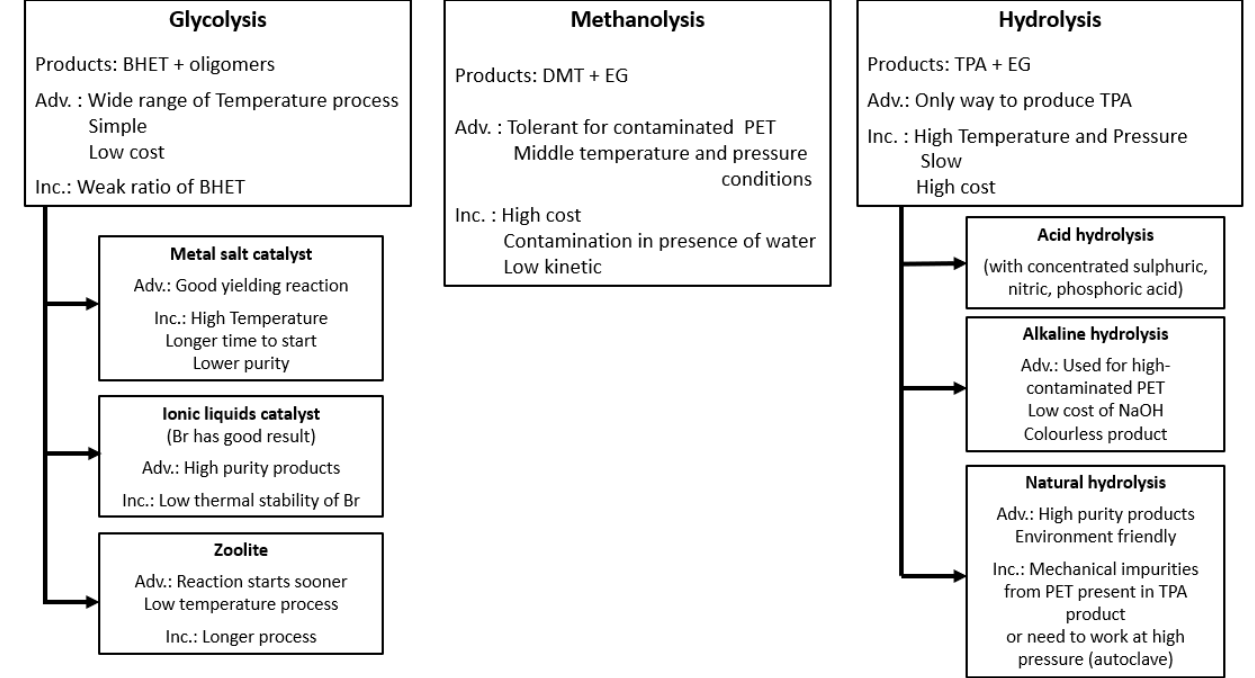
Figure 15. Presentation of major chemical treatments for PET recycling. The abbreviation “Adv” stands for advantages and “Inc” stands for limitations [249–251,282–286] .